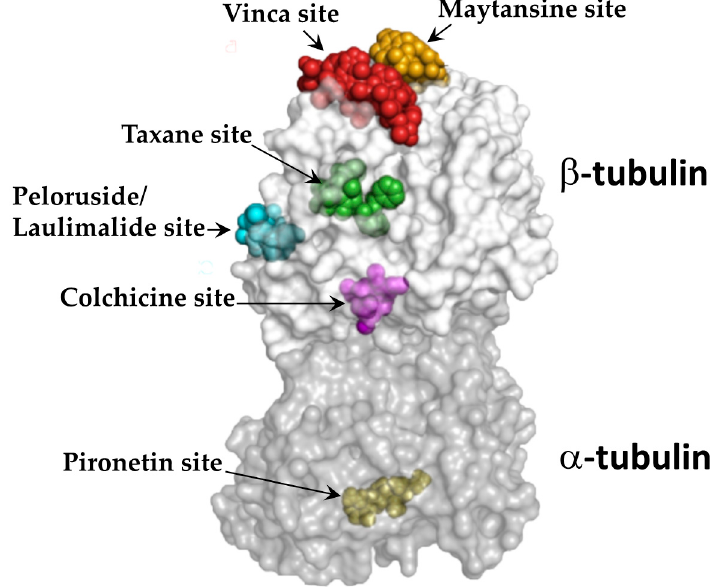
Figure 1. The known binding sites of microtubule-targeting agents on tubulin. The α -tubulin (dark grey) and β -tubulin (light grey) dimers with bound ligands are presented in semitransparent surface. The representative ligand structures for each site were superimposed onto their appropriate binding sites. The image is adapted from Steinmetz MO and Prota AE [14] by obtaining Copyright clearance from the publisher, Elsevier, and the permission from the authors.